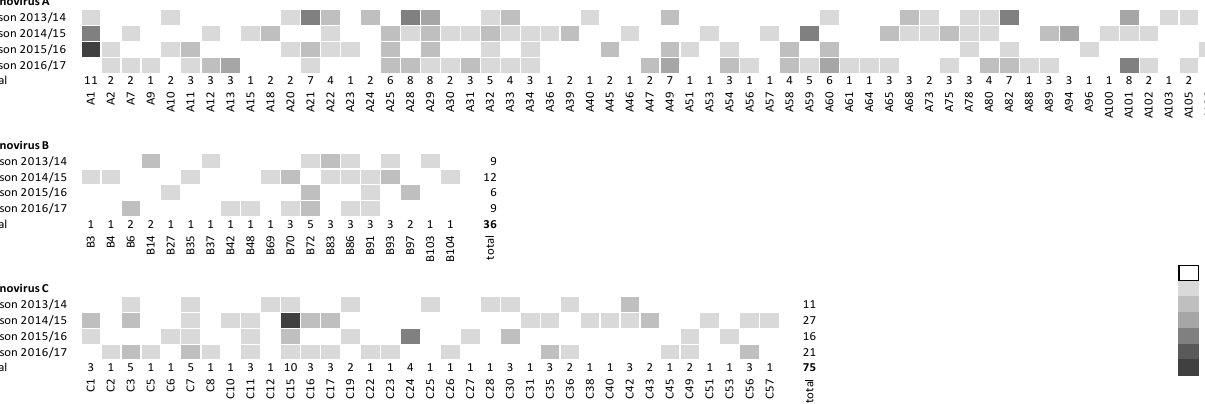
Figure 2. Heat map of the total numbers of RV genotypes ( n = 284) detected during the study period stratified by season.